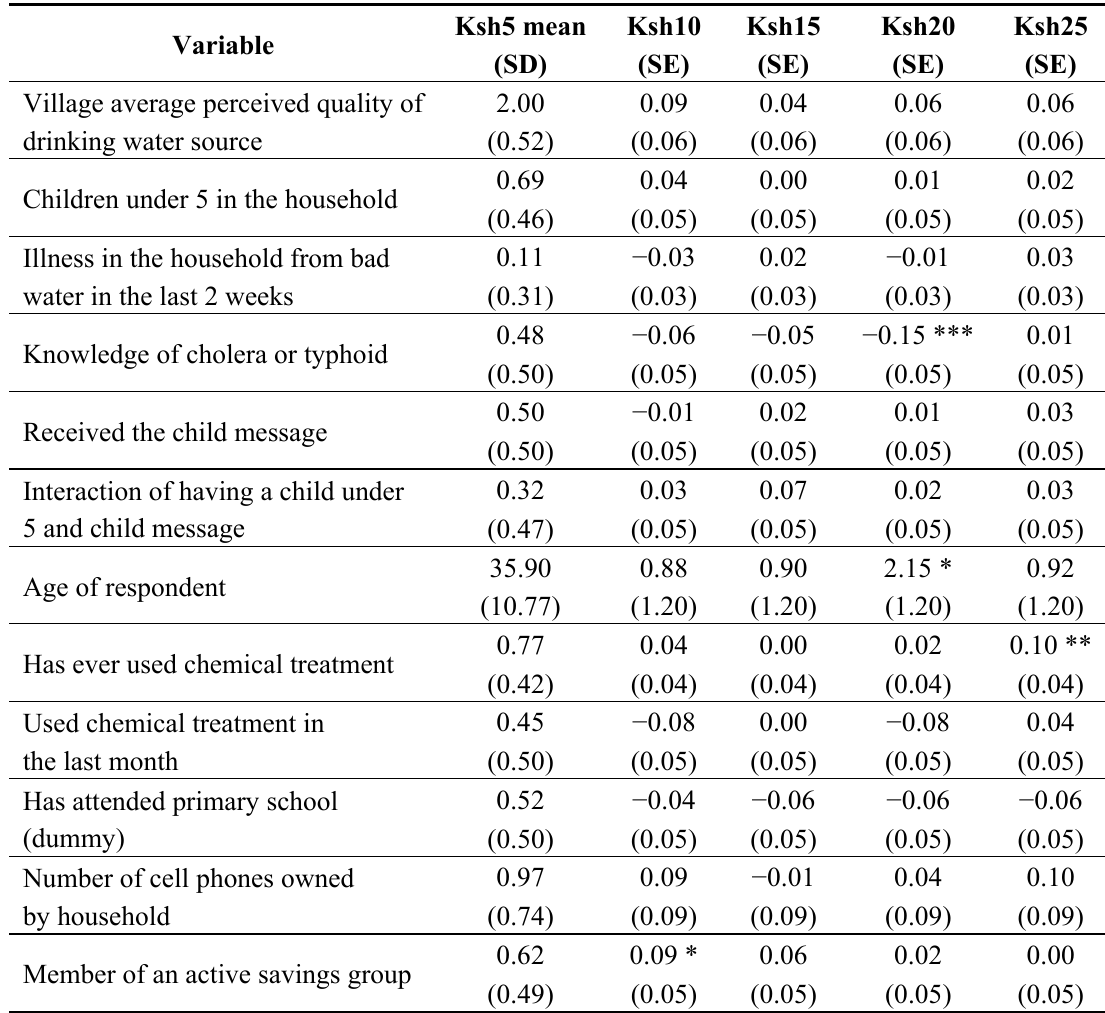
Table A1. Summary statistics of respondent and household characteristics across assigned promotional prices. Mean and standard deviation is reported for those offered a price of 5 Ksh. For groups offered 10, 15, 20, or 25 Ksh, the coefficient and standard error of each price dummy in a regression predicting each independent variable is displayed.